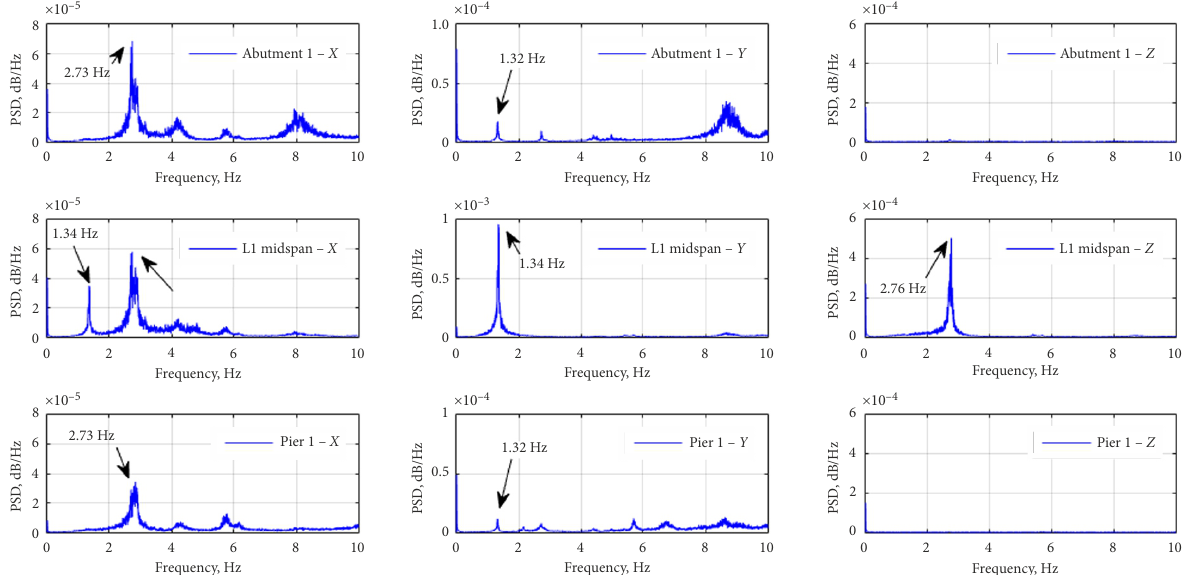
Figure 5. Frequency domain presentation of the signals for the first set of measurements in the first Ambient Vibration Survey